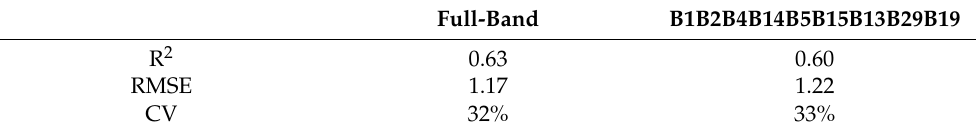
Table 4. LAI inversion comparison between the optimal band combination and the full band com- bination.